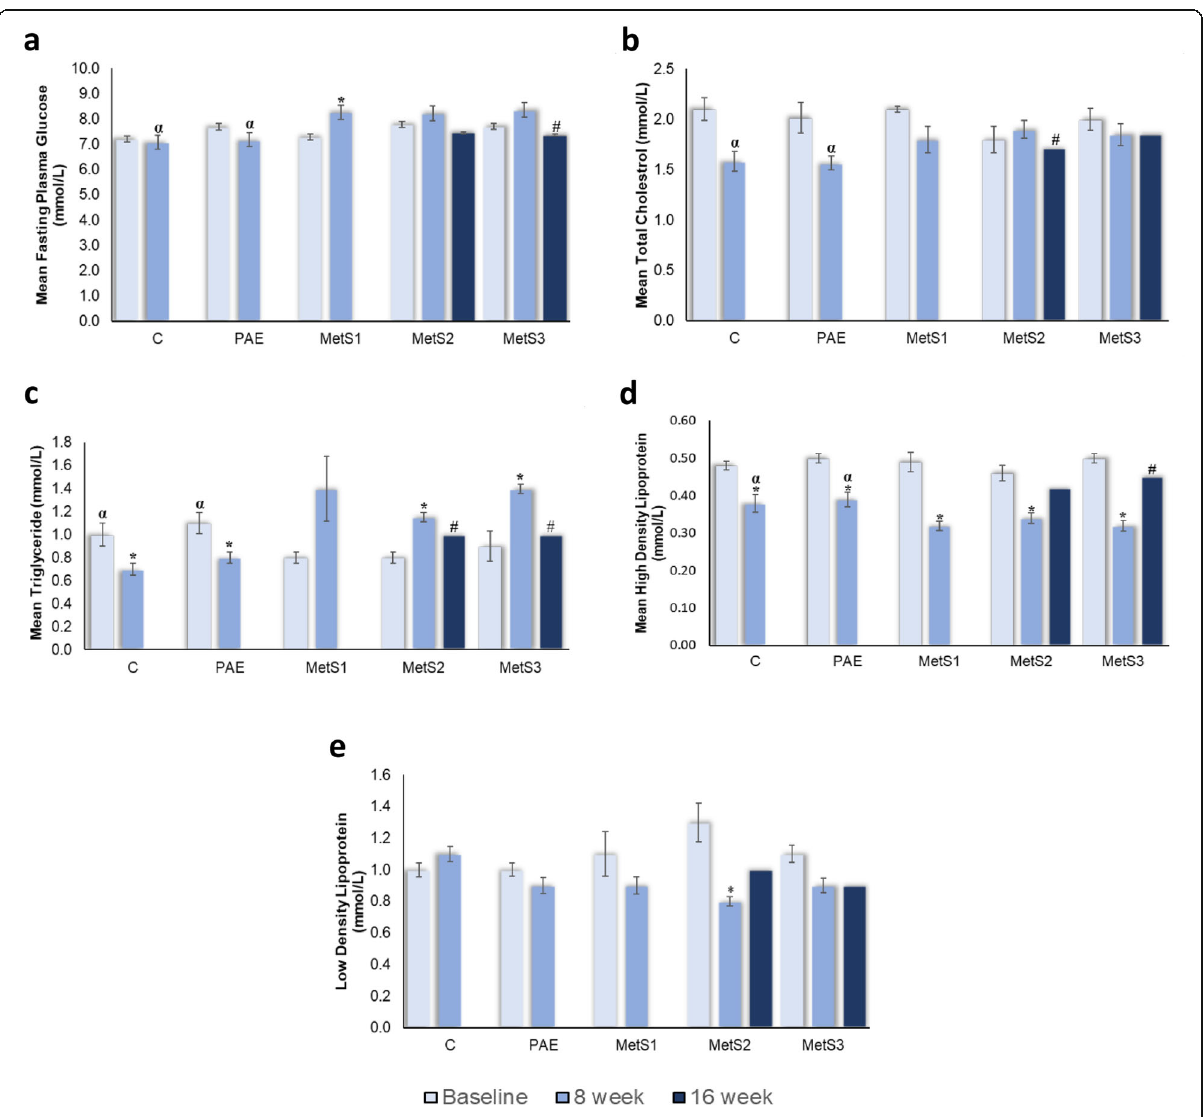
Fig. 4 Blood biochemistry effects on a FPG, b TC, c TG, d HDL and e LDL in C, PAE, MetS1, MetS2 and MetS3. n = 6. * p < 0.05 compared to 0th week. # p < 0.05 compared to 8th week. α p < 0.05 compared to